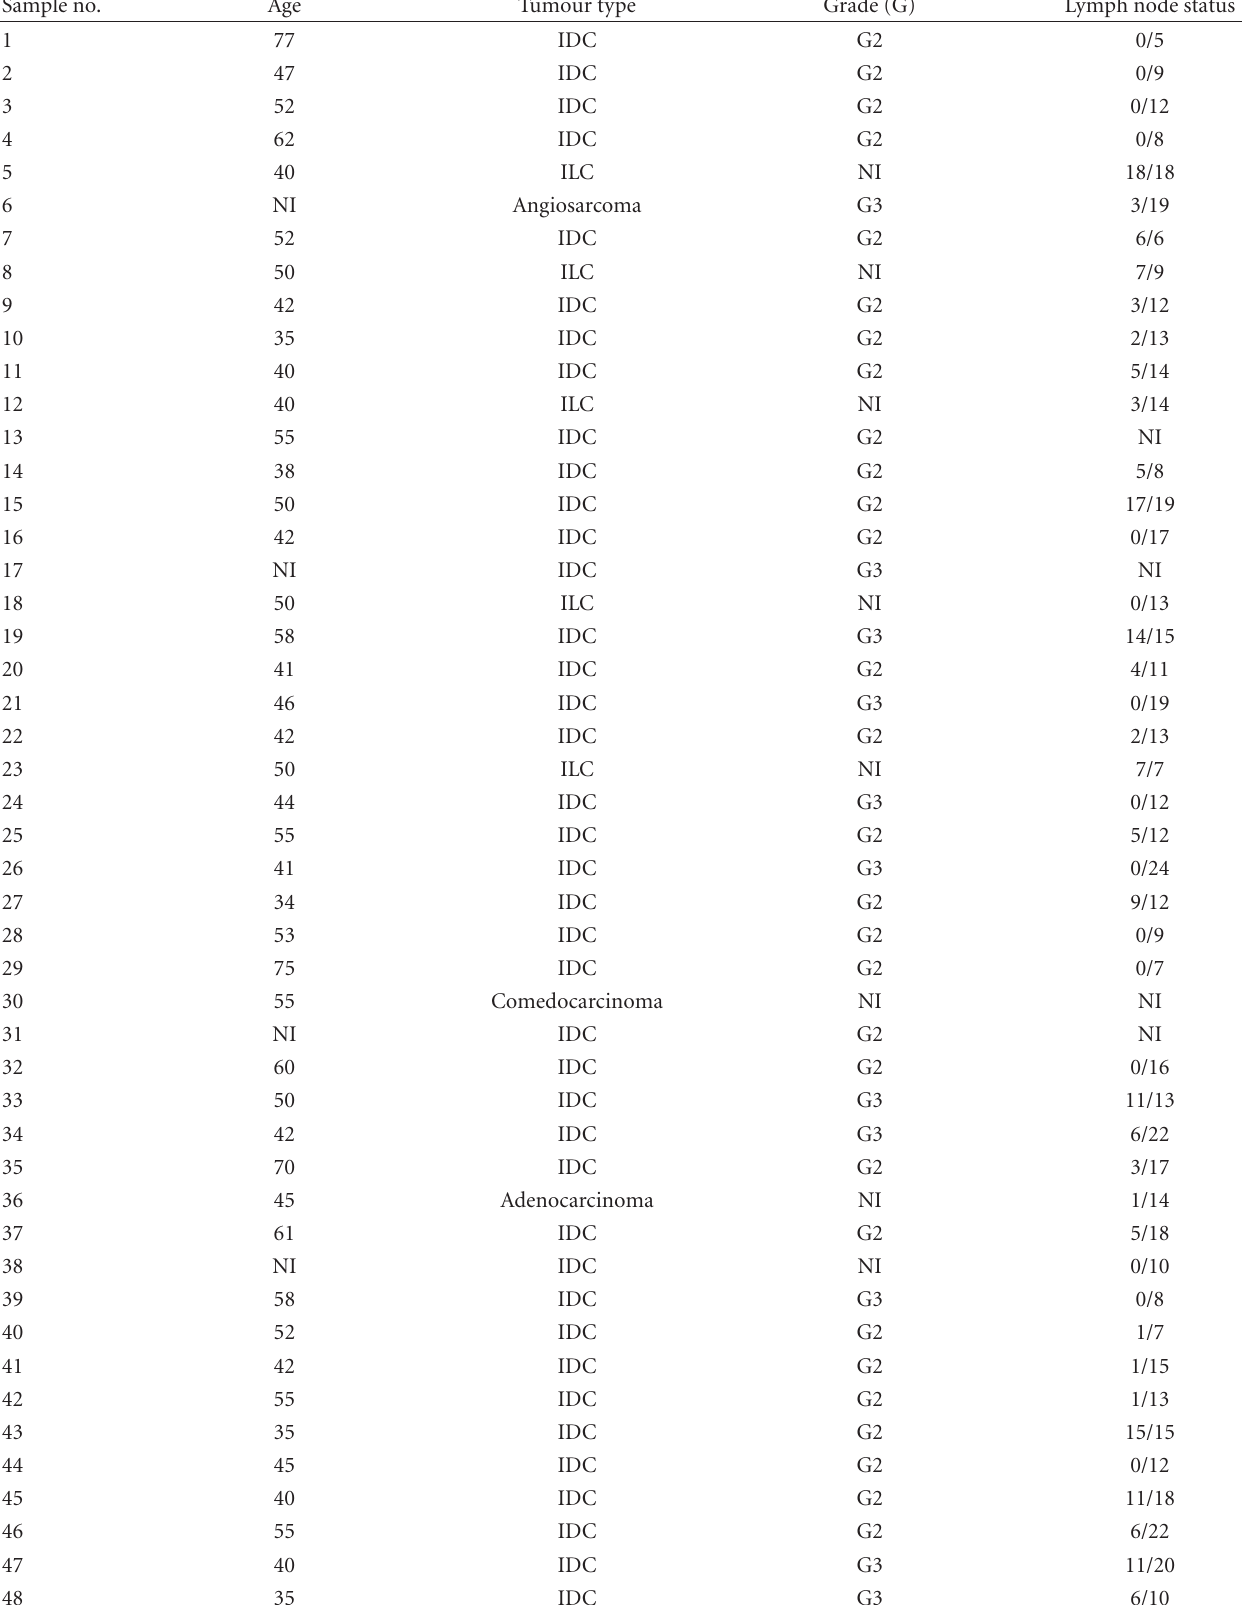
Table 1: Patients clinicopathological